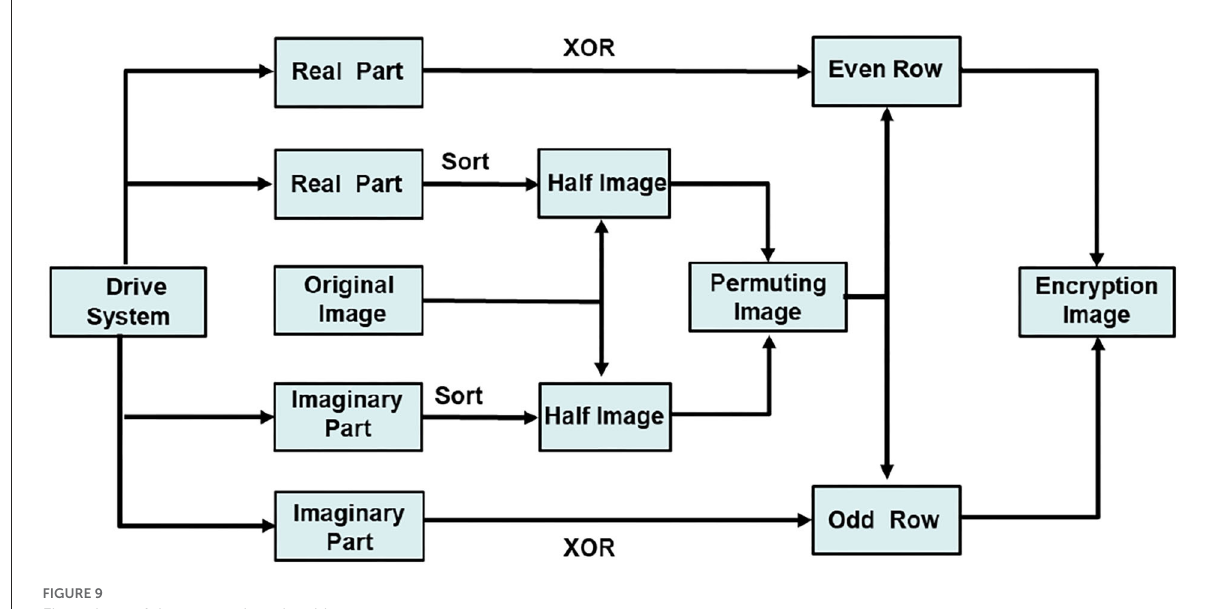
FIGURE9 Flow chart of the encryption algorithm.